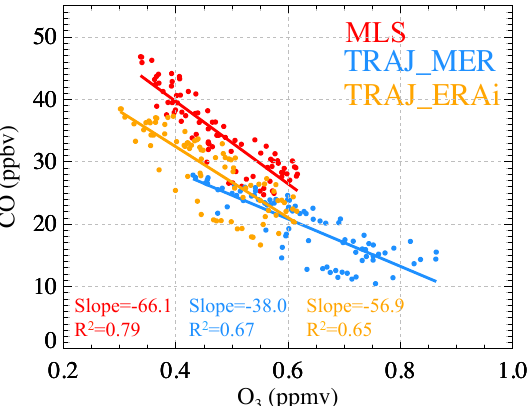
Figure 10. Monthly variations of O 3 vs. CO in the tropical lower stratosphere (15 ◦ N–15 ◦ S, 68hPa) from MLS and trajectory mod- eling driven by MERRA wind and ERAi wind. Trajectory results are weighted by the MLS averaging kernels.